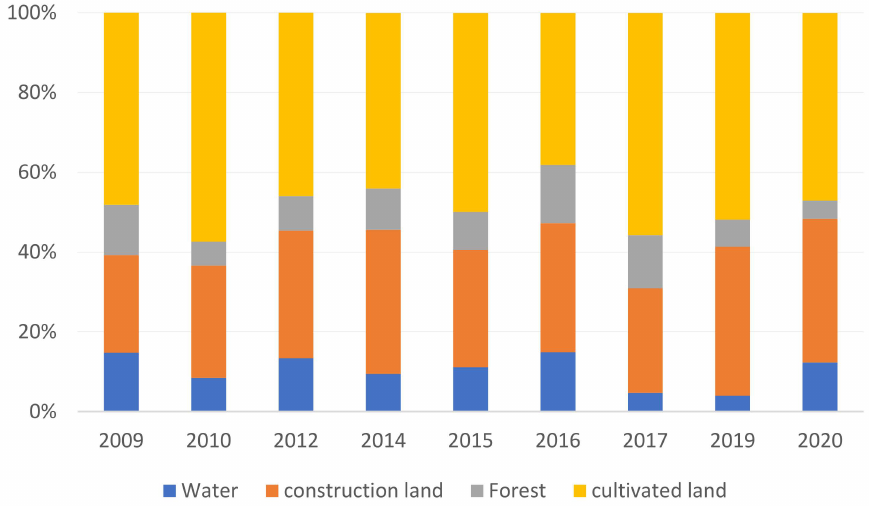
Figure 5. The area and proportion of various land-use types in the research